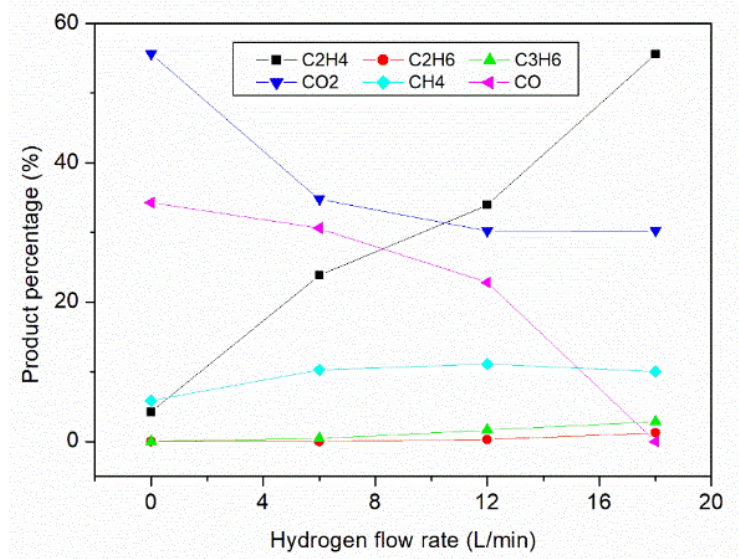
Figure 6. Effect of hydrogen flow rate on the percentage of the gas product.